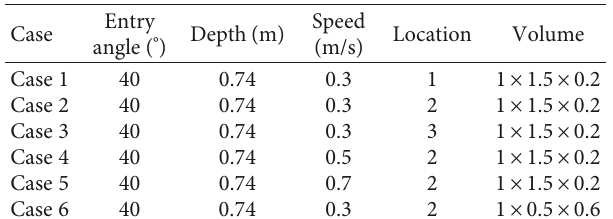
Figure 6: Roll motion decay curve. Table 2: Table of cases.